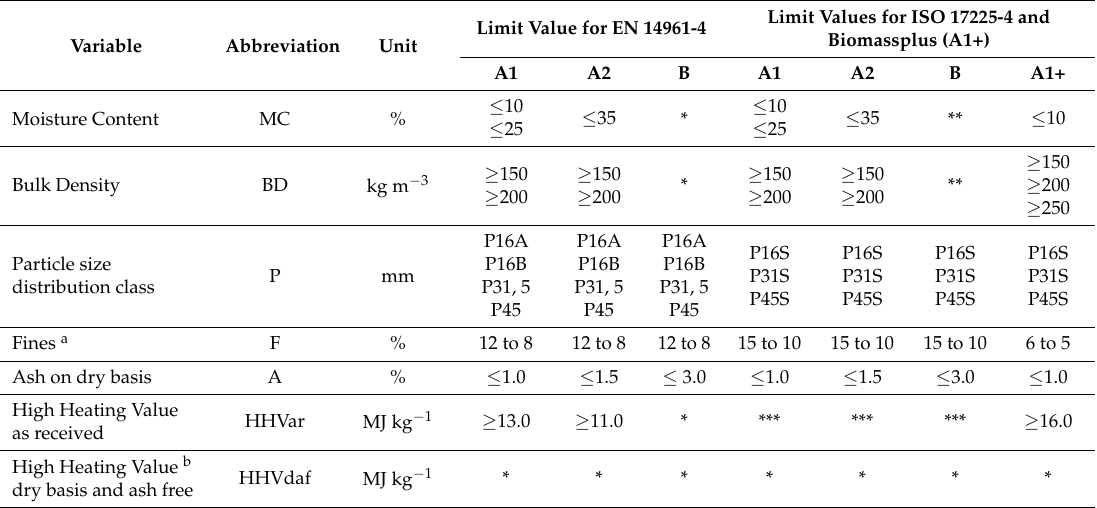
Table 2. Variables used in the SIMCA models and limit values set by standards.